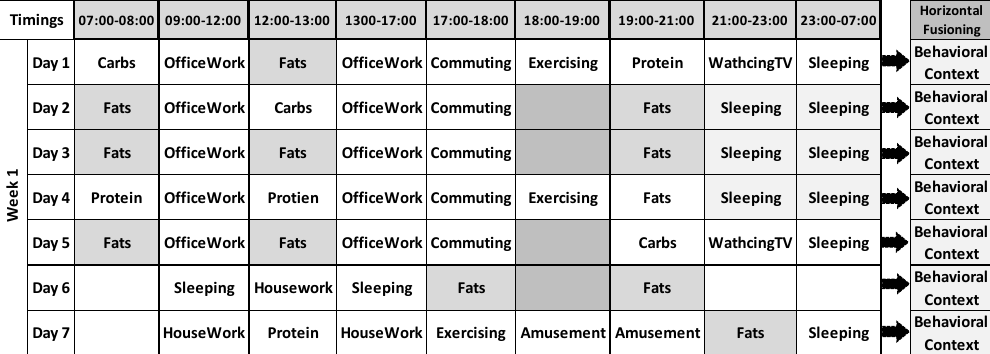
Figure 8. Illustration scenario explaining Horizontal